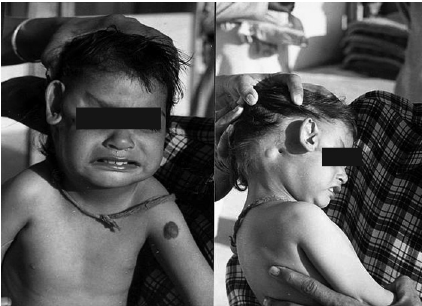
Figure 1. Ectopic Pinna - Right Pinna, displaced towards the lateral canthus of the Right eye. A tubercle present over the Right Mastoid region near the External Auditory Canal.A Hemangioma over left